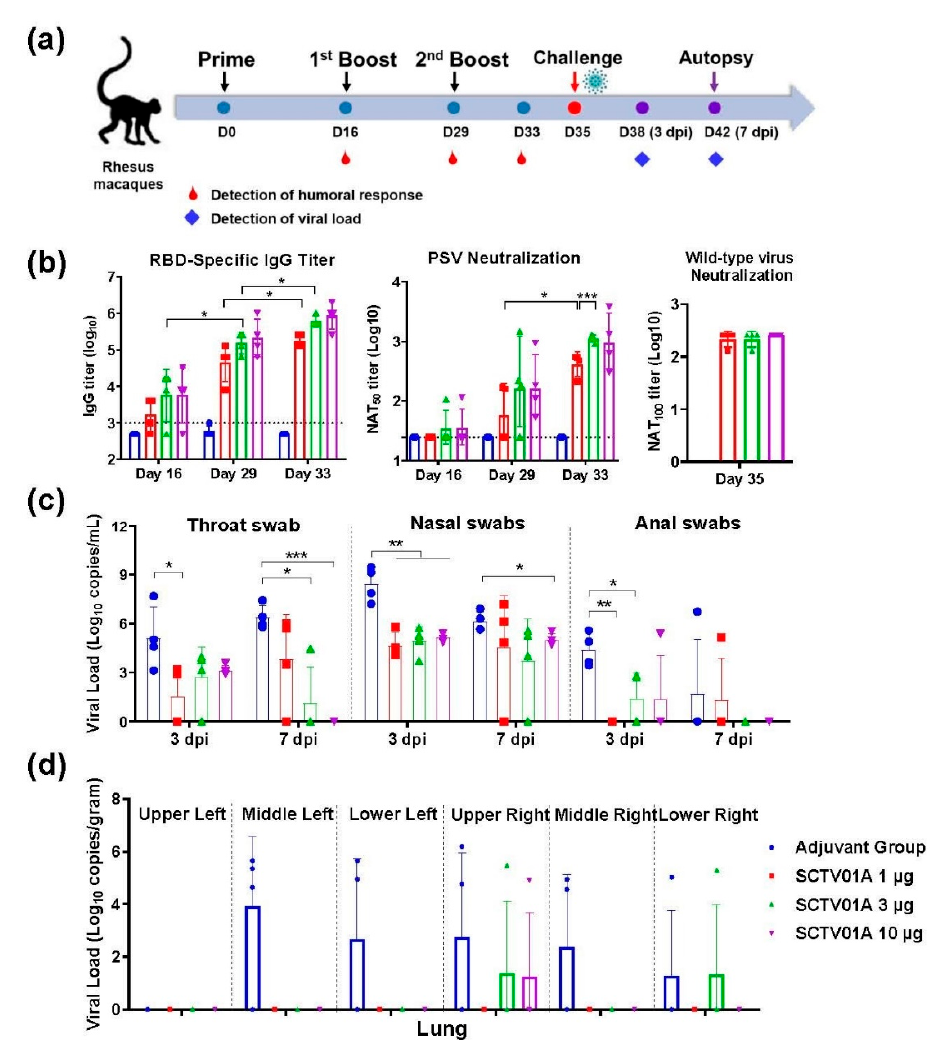
Figure 3. Immunogenicity and protective efficacy of SCTV01A in rhesus macaques. ( a ) Immunization and challenge procedures for rhesus macaques. Rhesus macaques (n = 4/group) were immunized with 1 µ g, 3 µ g, or 10 µ g SCTV01A/SCT-VA02B on day 0, 16, and 29, respectively. The control group was treated with an equal volume of SCT-VA02B. The SARS-CoV-2 (Strain: GD108#) challenge was conducted on day 35. Swabs of throat, nasal, and anal were collected at 3 and 7 dpi. Macaques were sacrificed at 7 dpi. Tissues, such as lungs, heart, and liver, were collected. ( b ) RBD-specific IgG titer (left) and PsV NAT 50 titer (middle) at the indicated time points post-immunization. SARS-CoV-2 authentic virus neutralizing titer NAT 100 at Day35 (right). ( c ) Viral load of throat, nasal, and anal swabs at 3 dpi and 7 dpi. ( d ) SARS-CoV-2 viral load was determined using RT-qPCR at 7 dpi in lungs. Statistical analyses were performed using unpaired two-tailed Welch’s tests. * p < 0.05, ** p < 0.001, *** p < 0.0001.